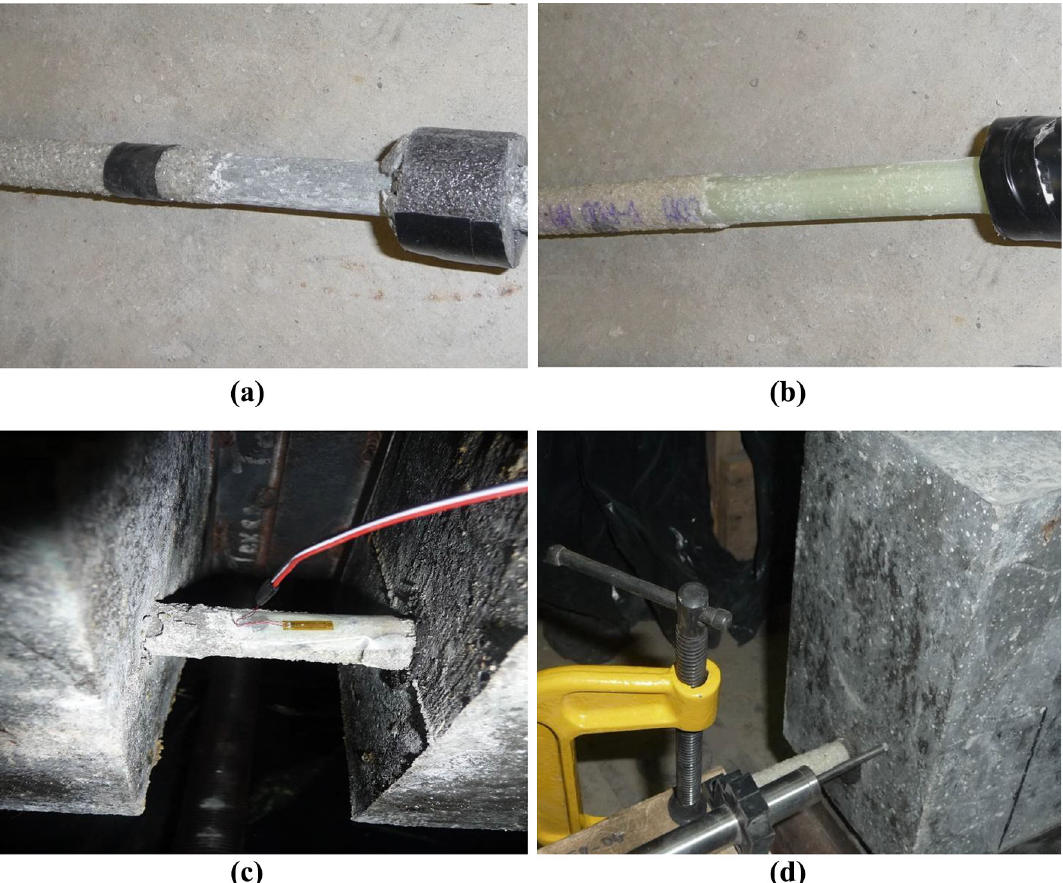
Fig. 11 a LM bar: partial delamination of sand coating, b HM bar: detachment of entire sand coating, c bar pullout from the left hand part showing outward movement and d bar pullout showing inward movement of the